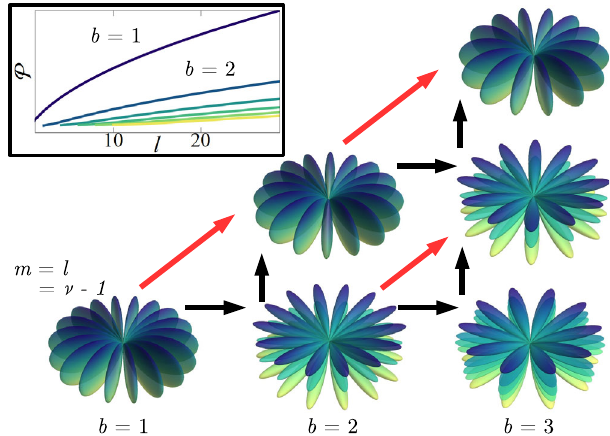
FIG. 7. Dependence of the band structure of a 2D Rydberg θ ; φ Þ into the plane. Shown composite on the projection of Y lm ð are a few spherical harmonics, starting in the bottom left-hand corner with the maximally circular state. Horizontal black (vertical black) arrows represent a decrease in m ( l ). States in the same column therefore are from the same block diagonal. Red diagonal arrows represent increases in k ¼ ν − l , starting from FIG. 6. The 2D Rydberg composite ’ s spectrum displayed as a k ¼ 1 in the bottom row. The inset shows the projection P as a dispersion relation, emphasizing the formation of energy bands. function of l for ν ¼ 30 for several b bands. Notice how much ˜ E larger the drop in energy is between bands compared to the gaps The black curves show ð m= ν Þ for ν ¼ 100 . The dashed red lines between k states within a are the asymptotic linearization of Eq. (17).